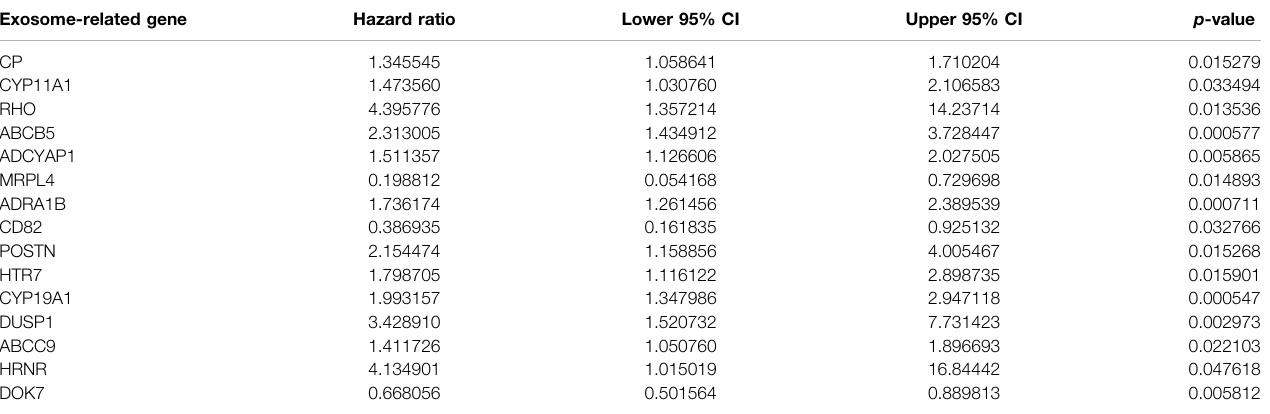
TABLE 1 | Prognostic exosome-related genes in GC via the univariate analysis. Exosome-related